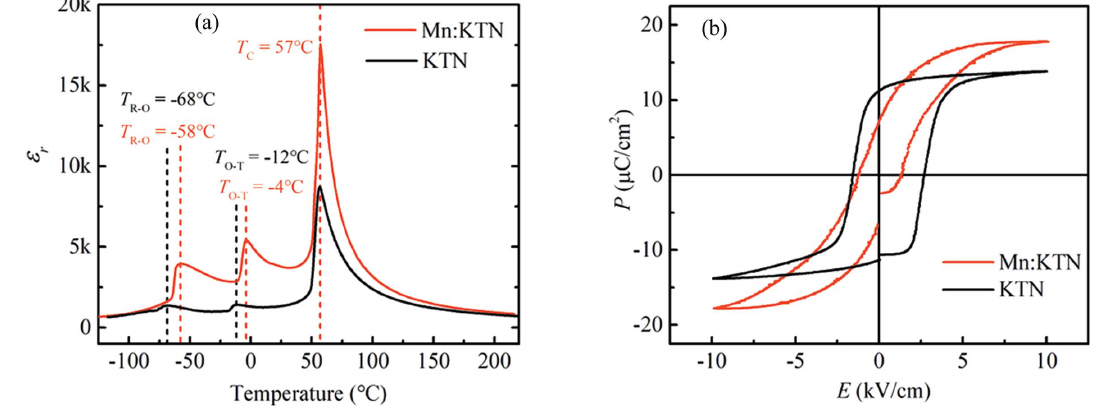
Figure 2 Dielectric and ferroelectric properties. ( a ) Temperature-dependences of the relative dielectric permittivity ( " r ) measured at 1 kHz and ( b ) P - E loops of Mn-doped KTN and pristine KTN at 25 (cid:4)